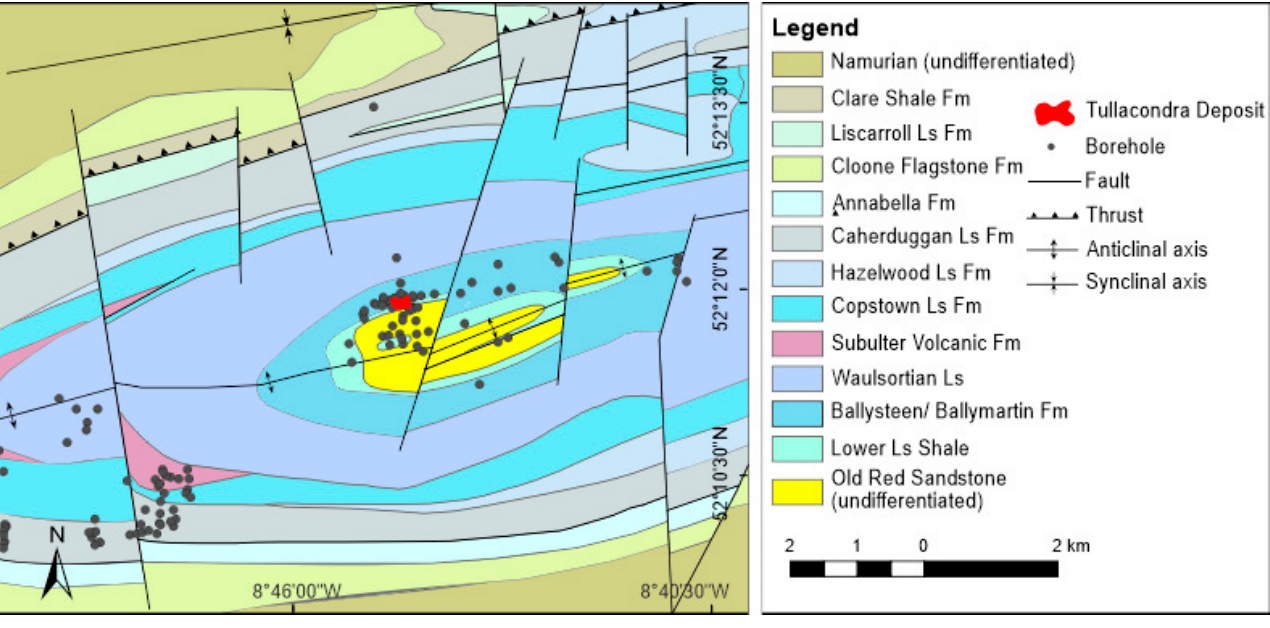
Figure 2. Geological map of the Kilmaclenine area showing the location of drill hole collars and the Tullacondra artisanal mine (red area). This map is based on data available by G.S.I (see in Data Availability Statement).